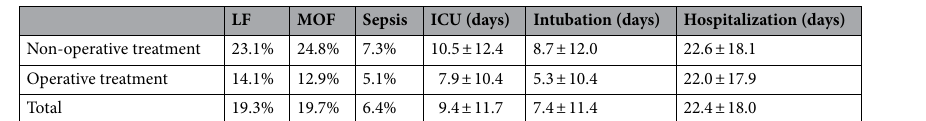
Table 2. Outcome parameters. LF lung failure, MOF multiple organ failure, ICU intensive care unit.